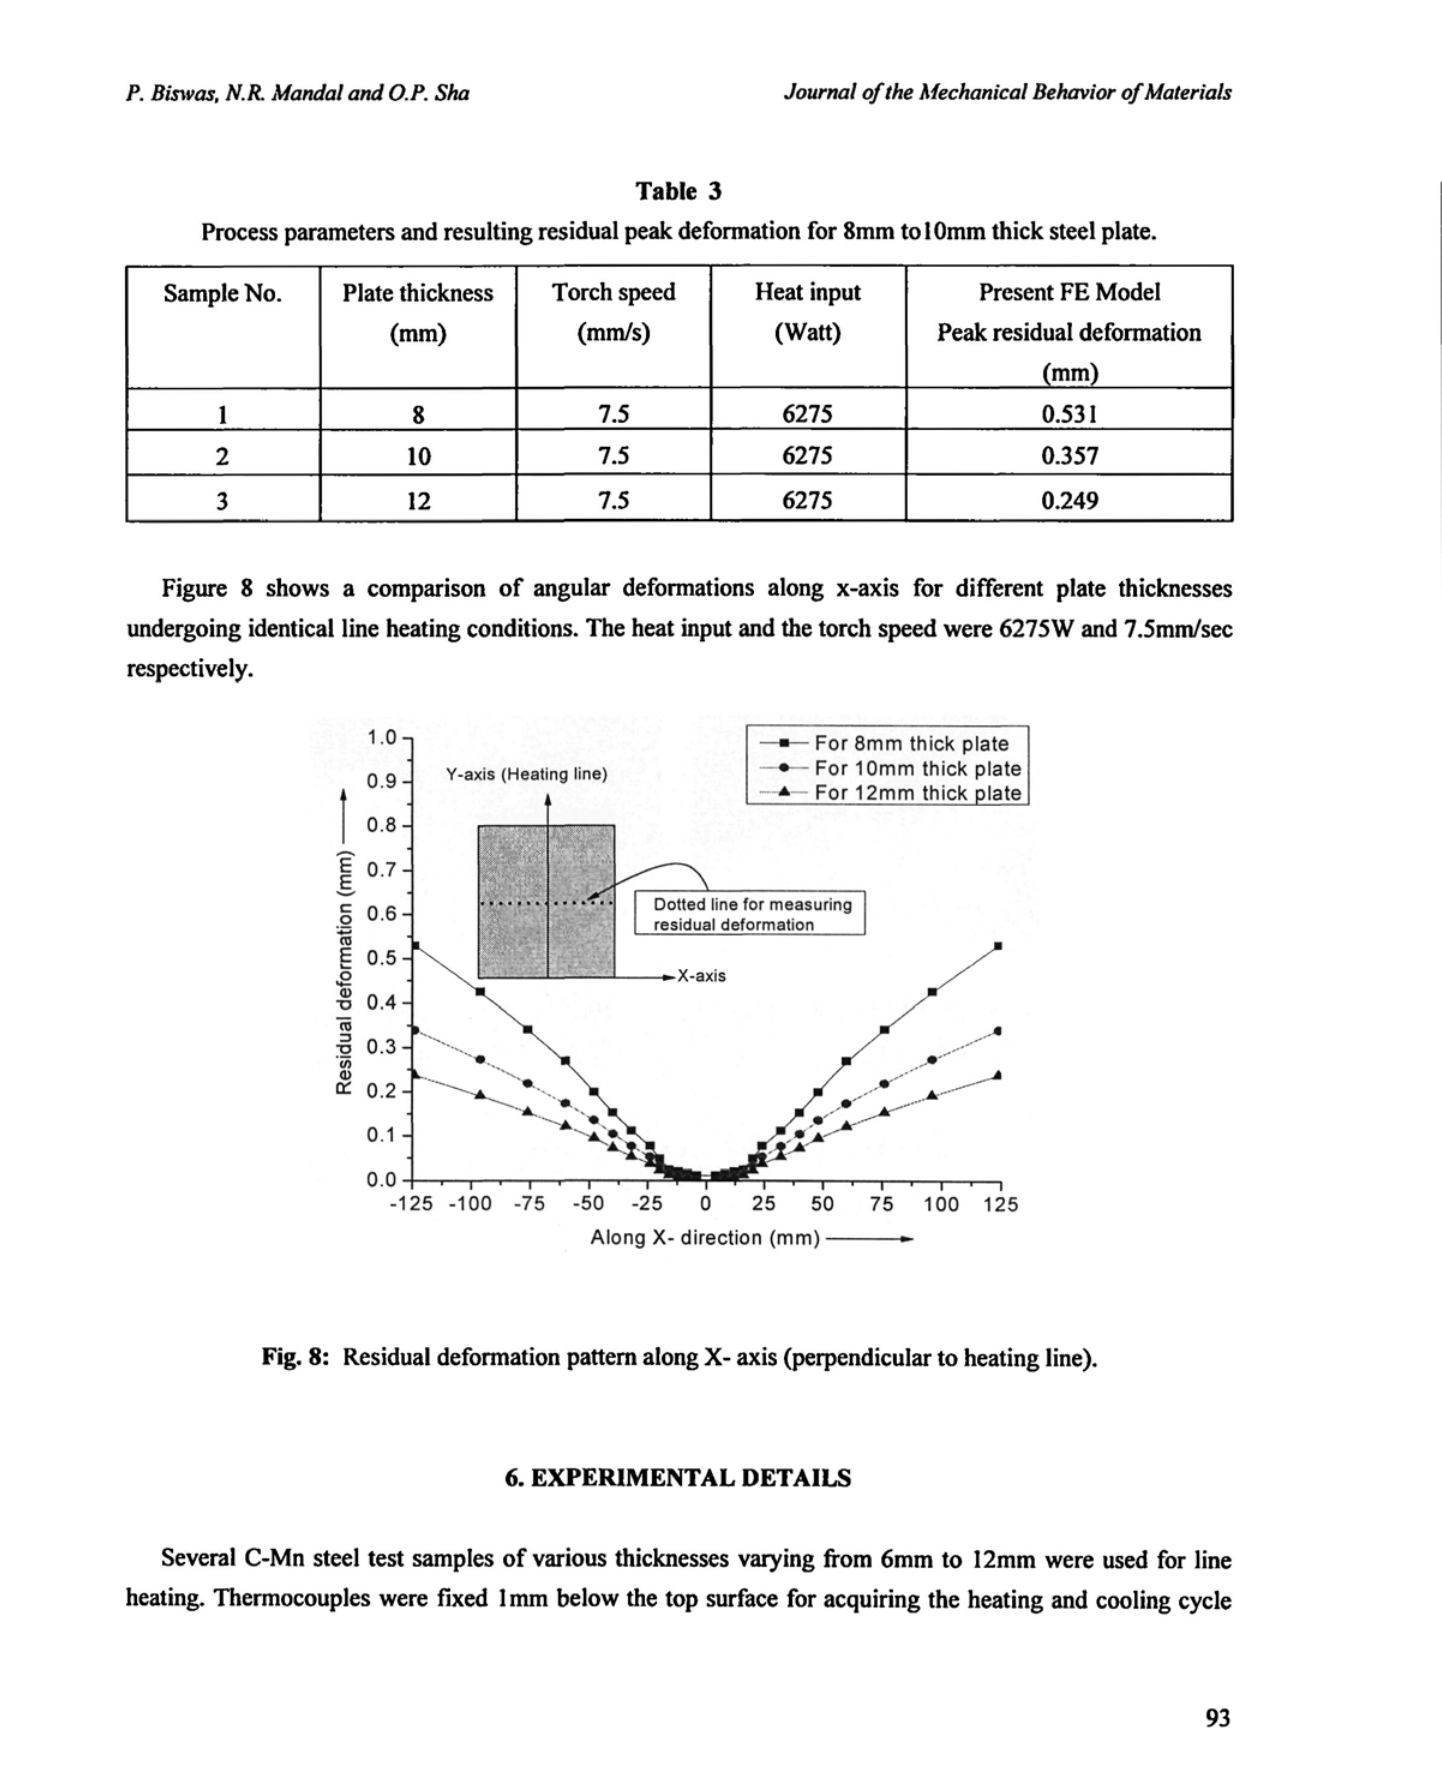
Fig. 8: Residual deformation pattern along X- axis (perpendicular to heating